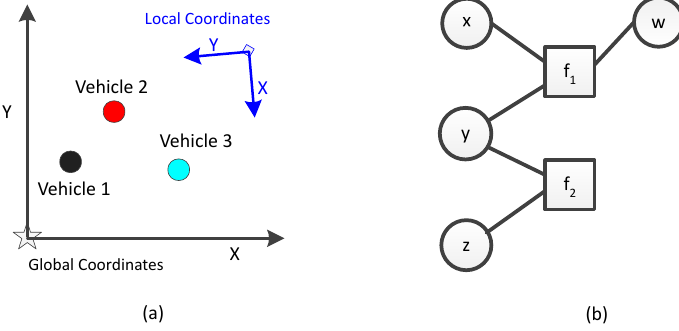
Figure 1. ( a ) Problem description with three vehicles. The local coordinate system is of the infrastructure sensor; ( b ) Factor graph with variables w , x , y , z and functions f 1 ( w , x , y ) and f 2 ( y , z )